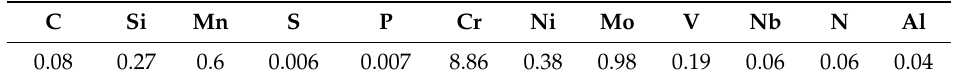
Table 1. Chemical composition of P91 steel (wt. %).